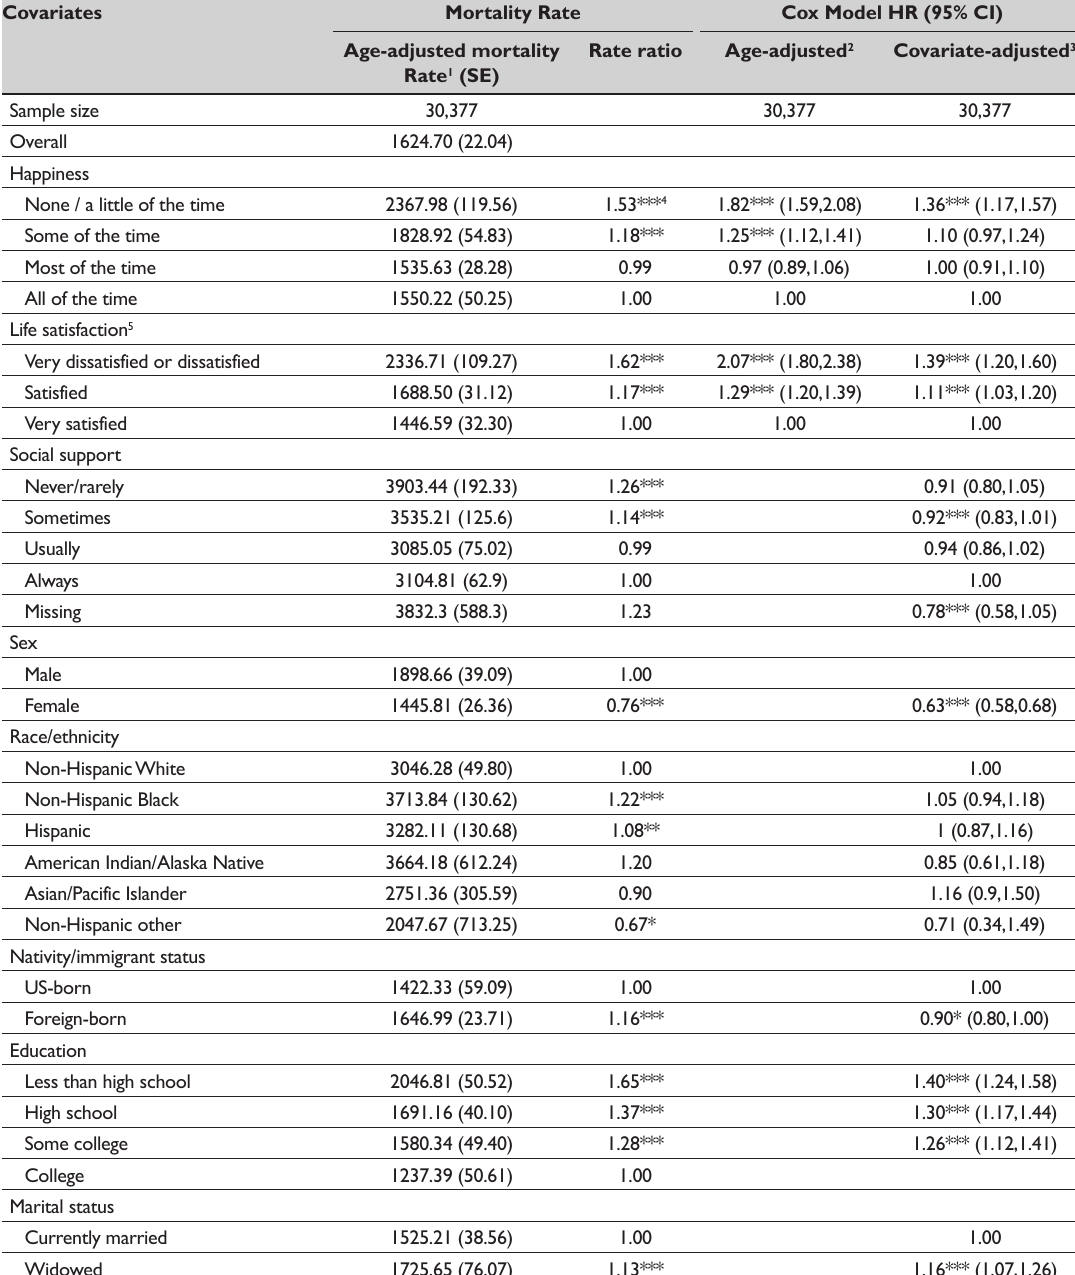
Table 3: Age-adjusted mortality rates per 100,000 person-years, and age-adjusted